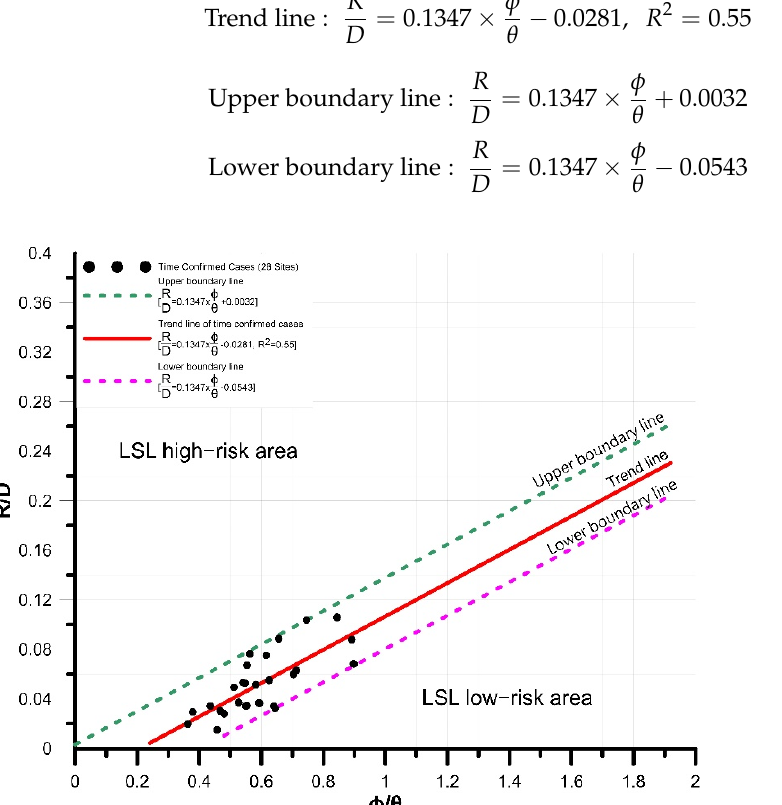
Figure 4. Dimensionless factor relationship of LSL cases with known occurrence time.